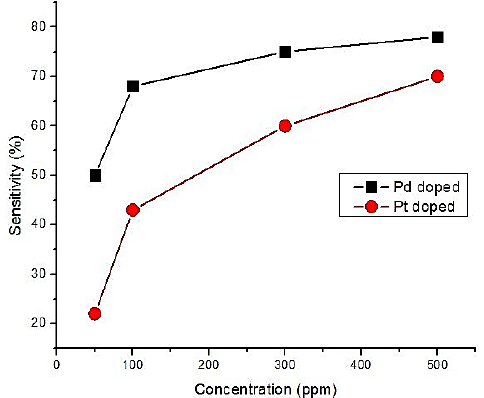
Figure 9. Sensitivity of 2% Pd-doped and 2% Pt-doped Tin Oxide thin film according to different concentrations of CO gas.